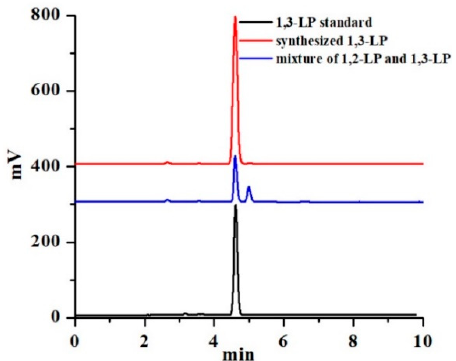
Figure 2. HPLC-ELSD analysis of 1-laurin-3-palmitin (1,3-LP). The peak area ratio of 1,3-LP to 1,2-LP